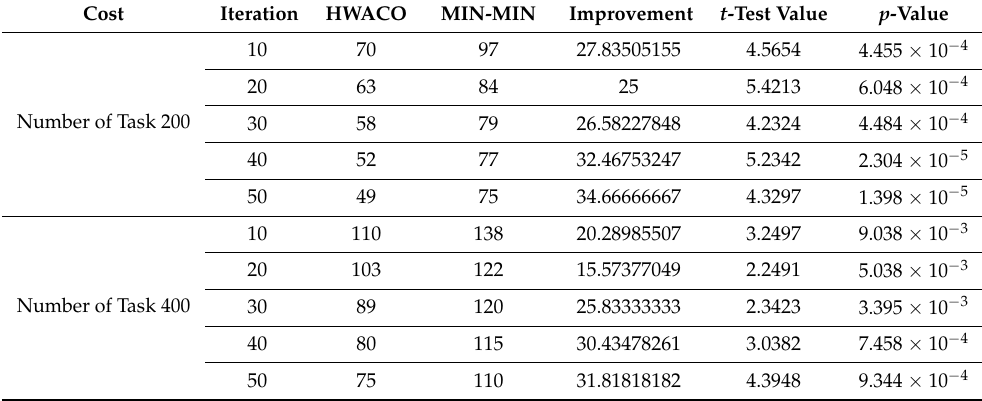
Table 12. t -Test for cost between HWACO and MIN-MIN.